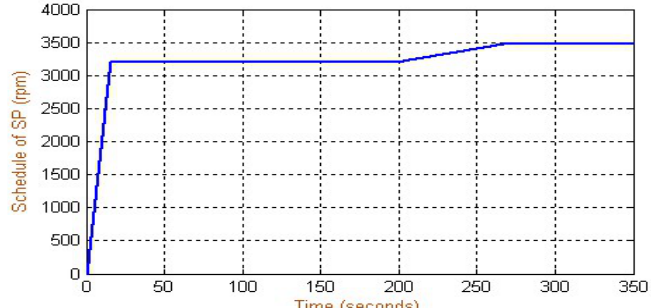
J. Mar. Sci. Eng. 2018 , 6 , x